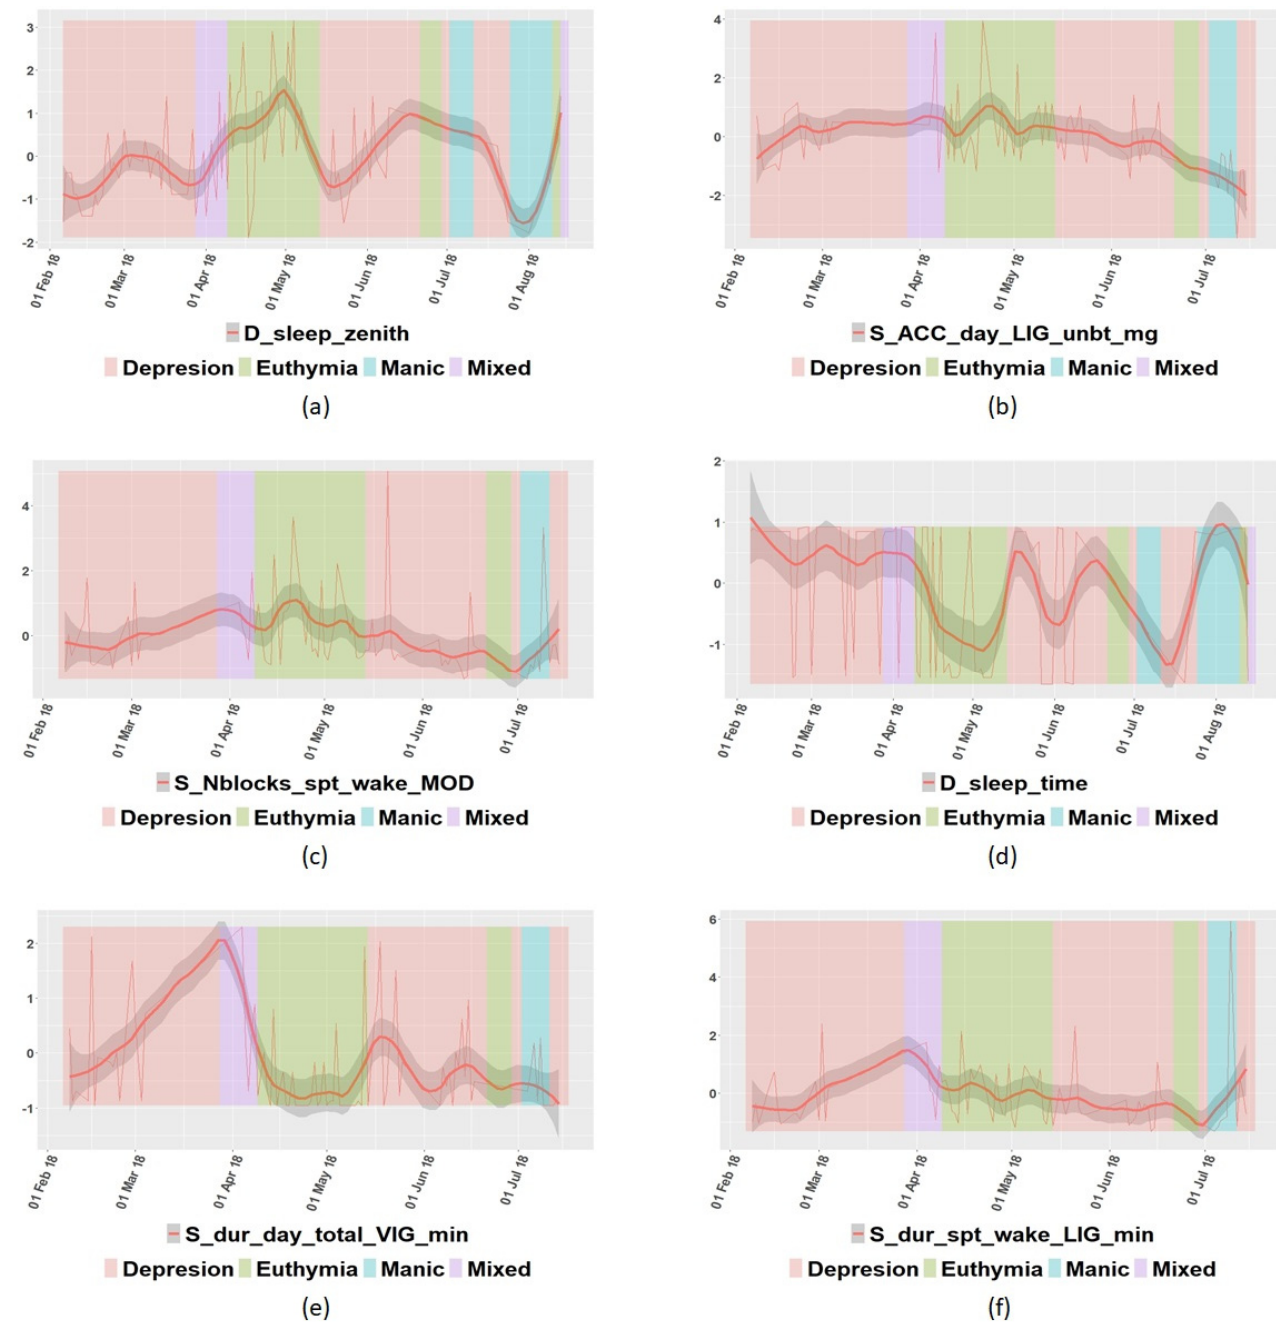
Figure 3. Graphical representation of some variables of patient P07: ( a ) sleep zenith; ( b ) acceleration in light state; ( c ) times of waking up in moderate state; ( d ) time to go to rest; ( e ) time spent in vigorous state; ( f ) time spent in light state in sleep period time.